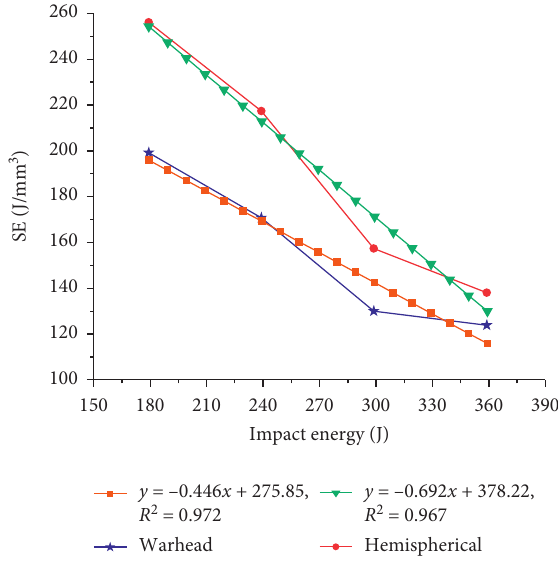
Figure 18: SE versus impact energy. Figure 16: Rock breakage volume versus impact